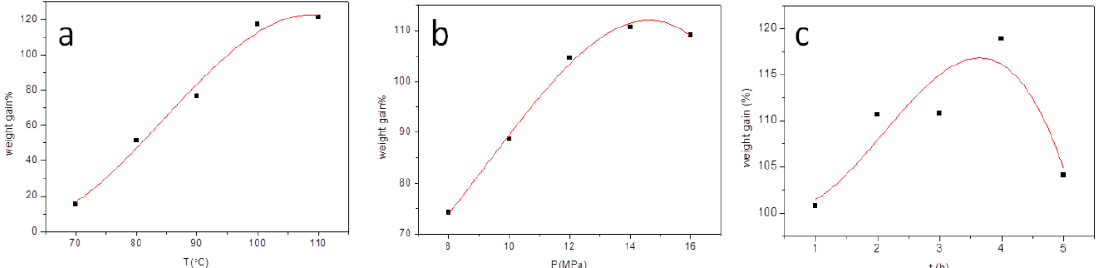
Figure 4. Change in WG % with reaction temperature ( a ), scCO 2 pressure ( b ), and reaction time ( c ). In ( a ), the scCO 2 pressure is 8 MPa and the reaction time is 2 h. In ( b ), the reaction time is 2 h and the reaction temperature is 100 °C. In ( c ), the scCO 2 pressure is 14 MPa and the reaction temperature is 100 °C.